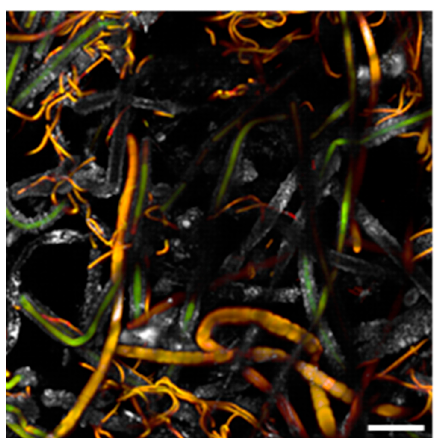
Figure 3. Biofilm sample taken from the wall of Room 93 and observed at the Confocal Laser Scanning Microscope (CLSM); the biofilm is dominated by S. julianum (thick filaments) and Leptolyngbya sp. (thin filaments). Scale bar = 40 μ m.